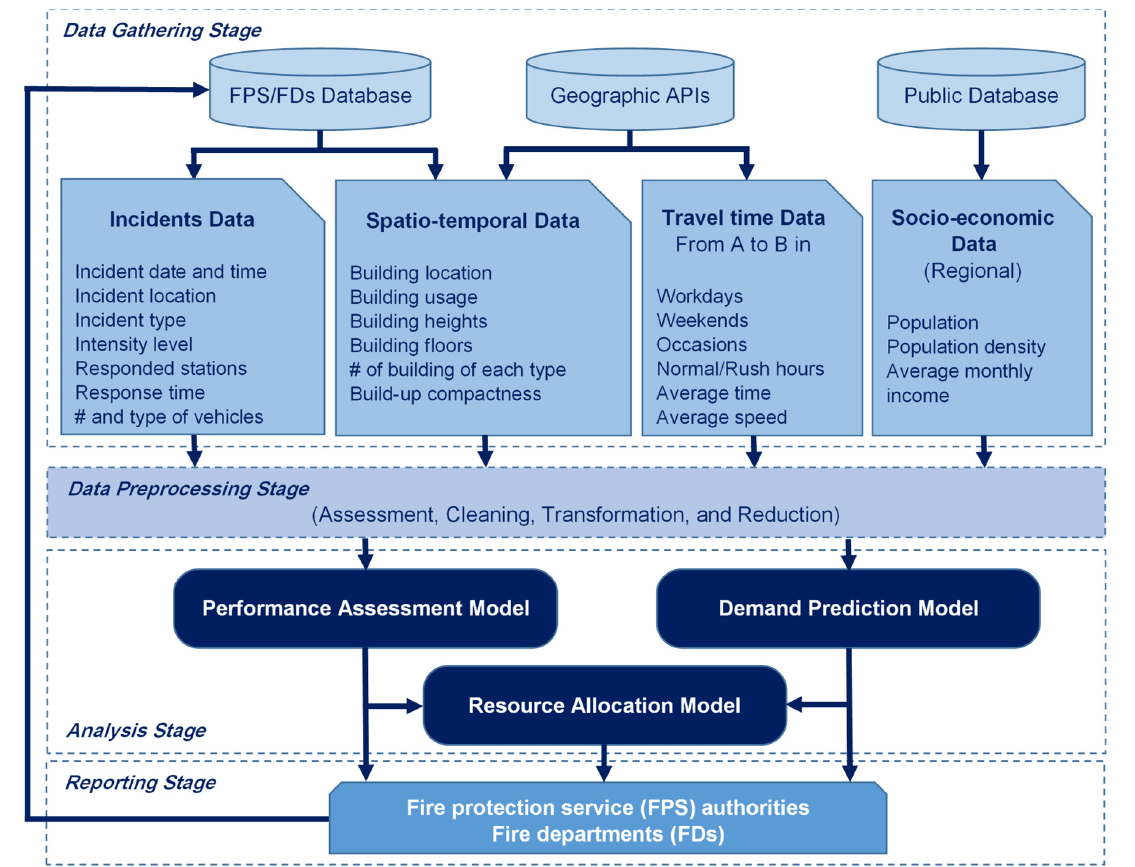
Figure 4. General framework for resource allocation in fire departments (RAFDF).